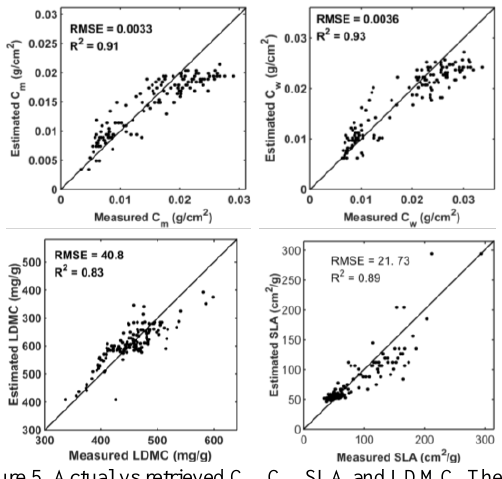
Figure 5. Actual vs retrieved C m , C w , SLA and LDMC. The solid line shows the1:1